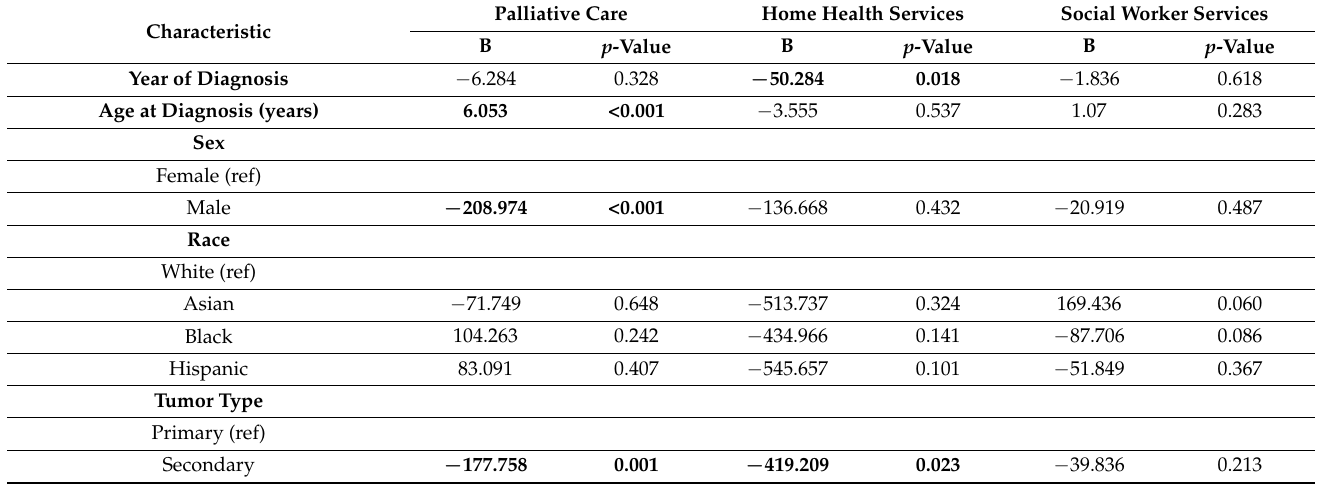
Table 3. Mixed effects model evaluating supportive care service